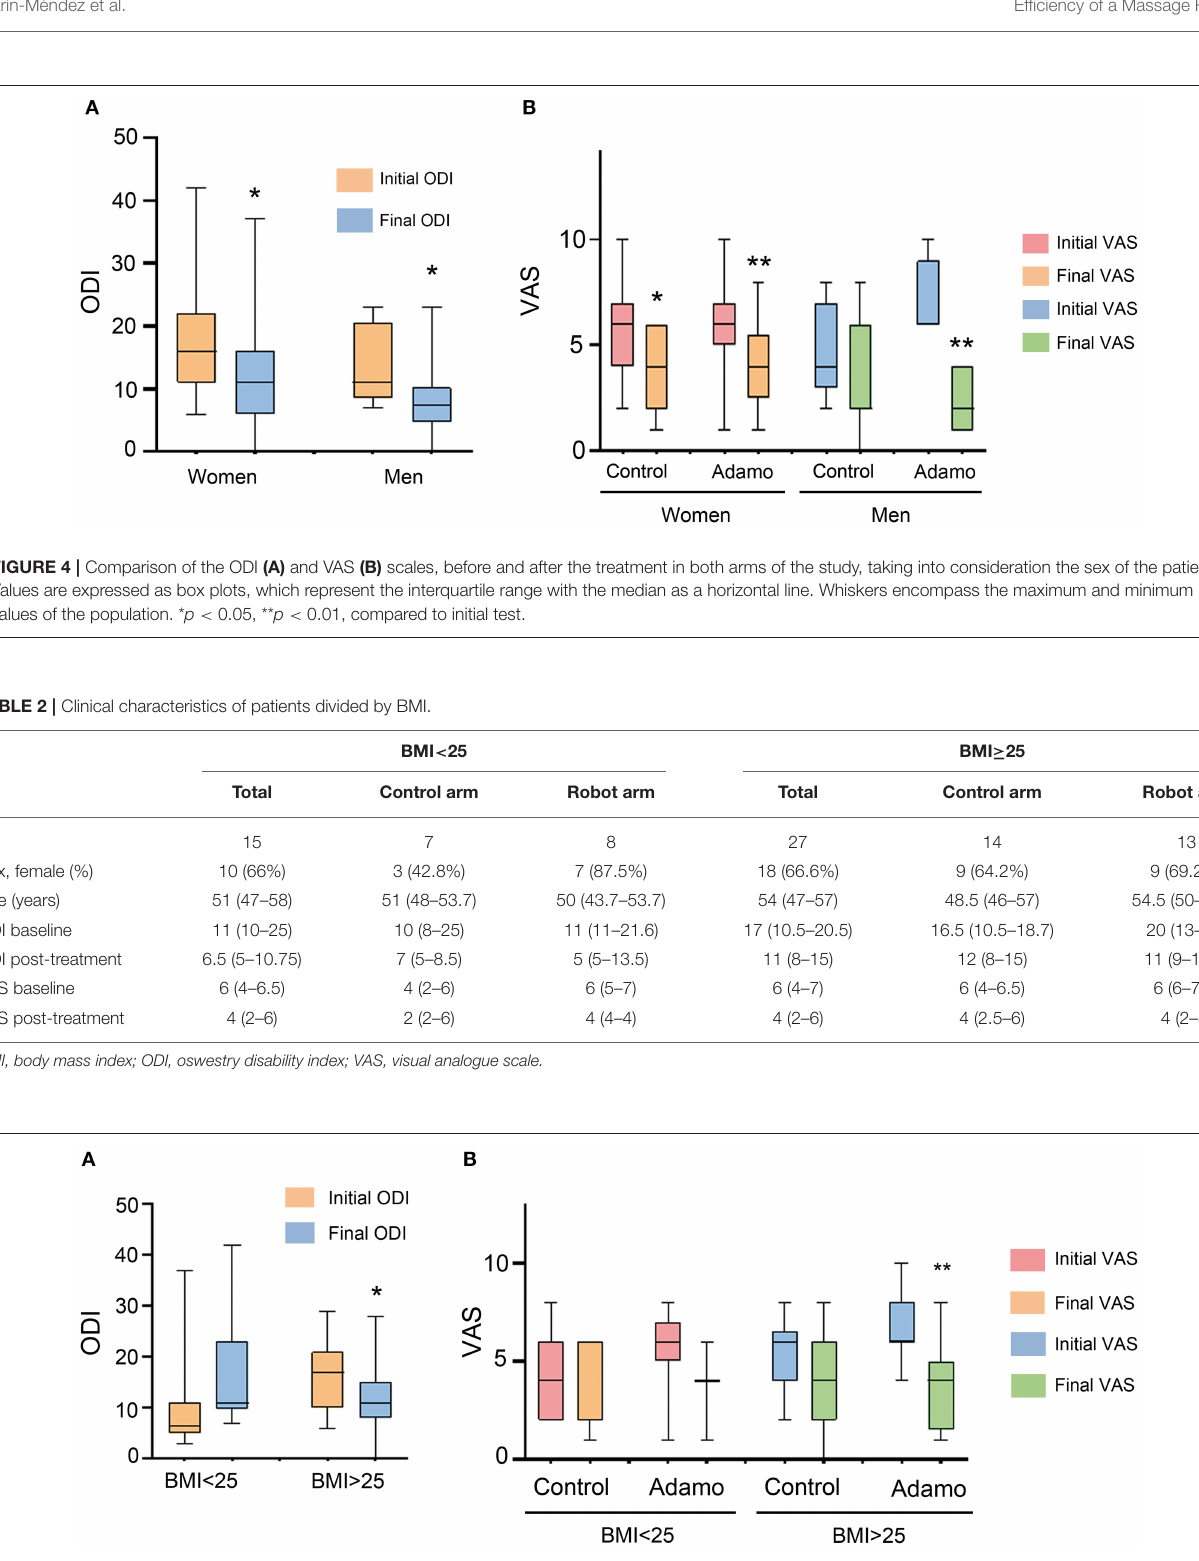
FIGURE 5 | Comparison of the ODI (A) and VAS (B) scales, before and after the treatment in both arms of the study, taking into consideration the BMI of the patients. Values are expressed as box plots, which represent the interquartile range with the median as a horizontal line. Whiskers encompass the maximum and minimum values of the population. * p < 0.05, ** p < 0.01, compared to initial test.